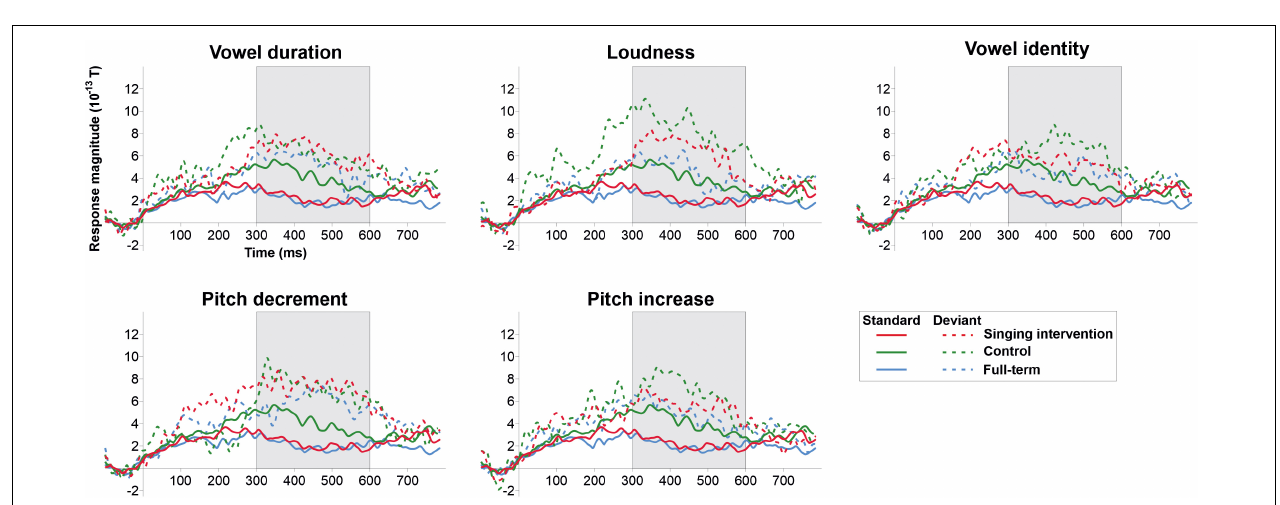
FIGURE 1 | ERP responses to the standard tones (solid lines) and deviant tones (dashed lines) for all groups in the oddball paradigm. Grayed area denotes the predefined MMR time window.